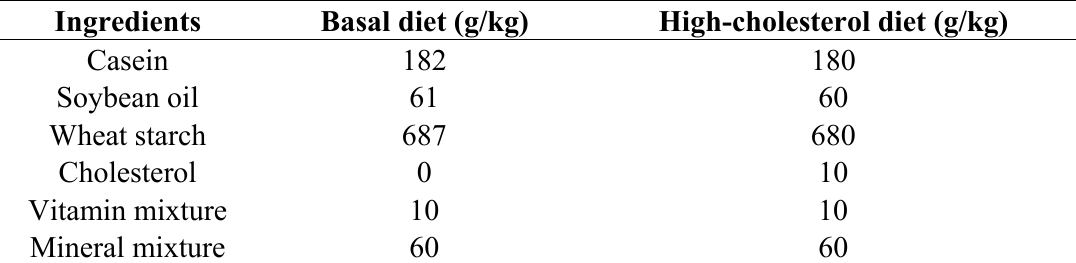
Table 2. Composition of animal